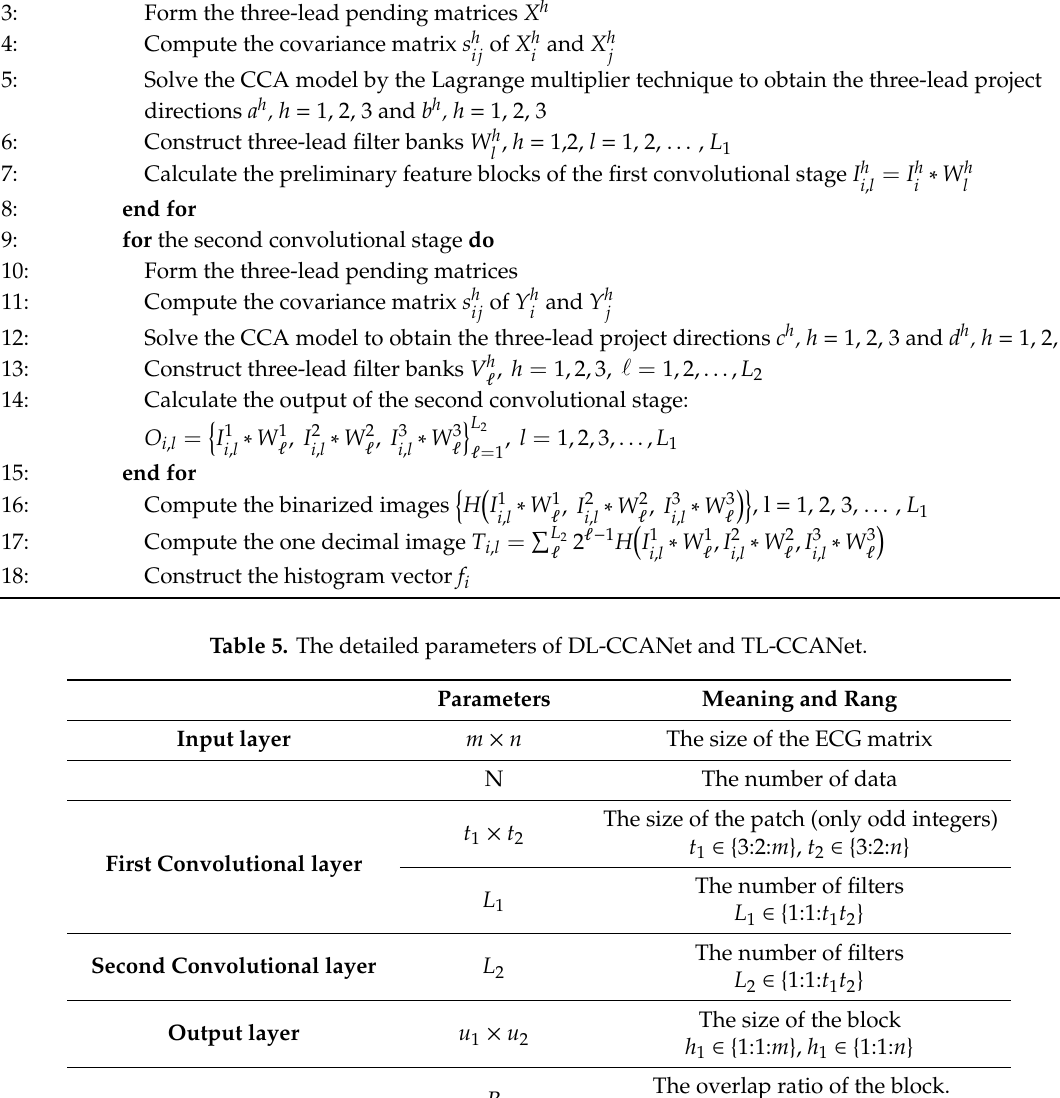
Algorithm 1. The algorithm of two convolutional stages of the DL-CCANet.